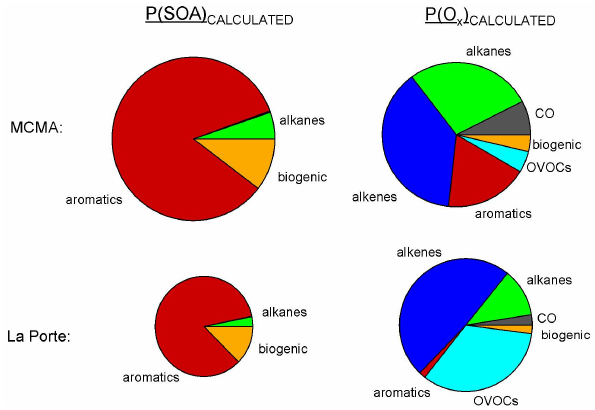
Fig. 7. Relative contributions of precursors to SOA and O x produc- tion calculated using VOC measurements at T0 in Mexico City at 06:30, 29 March 2006 and at La Porte at 14:00, 31 August 2000. Pie charts are not shown to scale (i.e., since absolute P (O x ) and P (SOA) rates depend on [OH], the sizes of the La Porte and Mex- ico City pie charts should not be compared